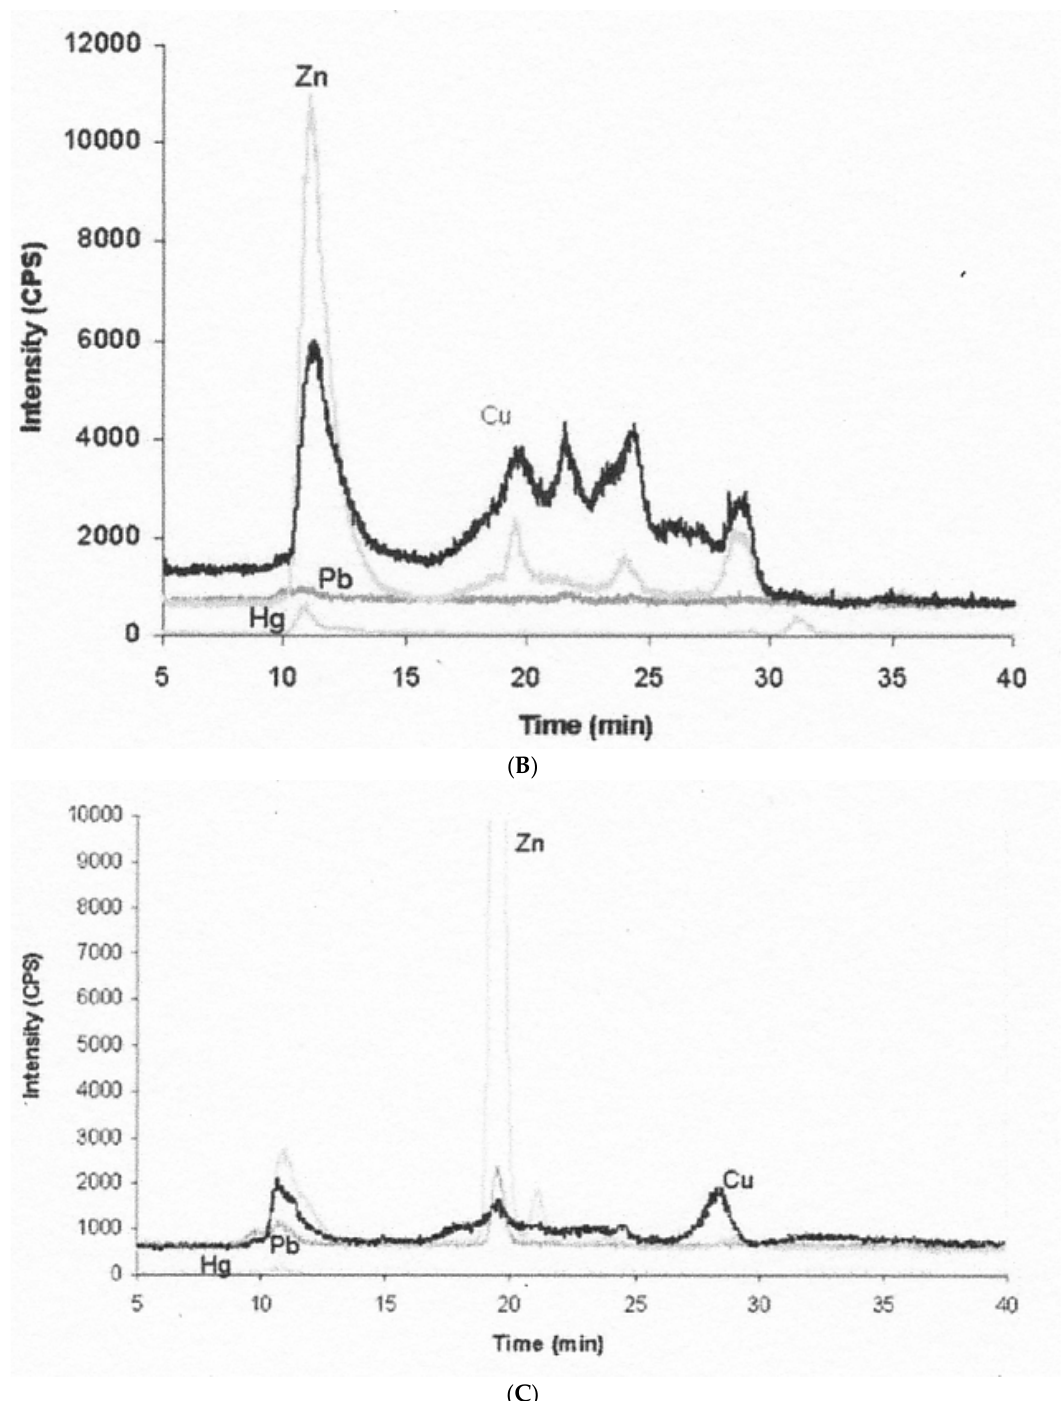
Figure 5. Metallothionein (MT) and other Cu components in fish bile separated in size exclusion chromatography (SEC) coupled to ICP-MS. Bile samples were first heated to remove most other proteins by precipitation, and the supernatants (containing MT) were applied to SEC. Elution of Cu and some other metal ions is shown for bile obtained from fish in uncontaminated waters ( A ), in Cu contaminated waters ( B ), and in waters containing excess Zn ( C ). X-axis is time (from 5 to 40 min); Y-axis is metal isotope intensity for Cu (black), Zn (light grey), as well as Pb (dark grey) and Hg (very pale). Reprinted with permission from Hauser-Davis et al. [51].